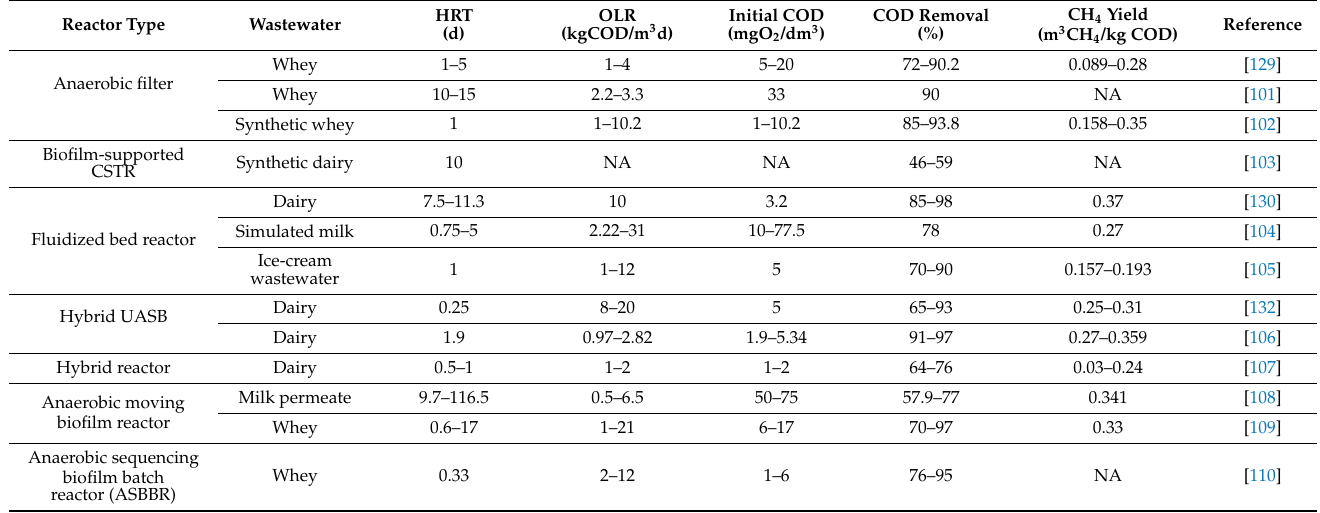
Table 6. Digestion performance vs. wastewater HRT and